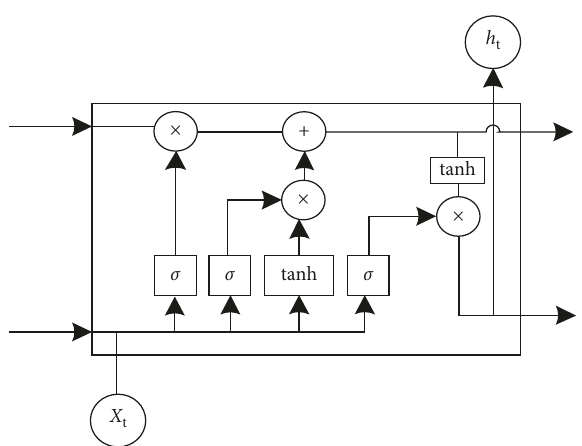
Figure 1: The internal structure of an LSTM